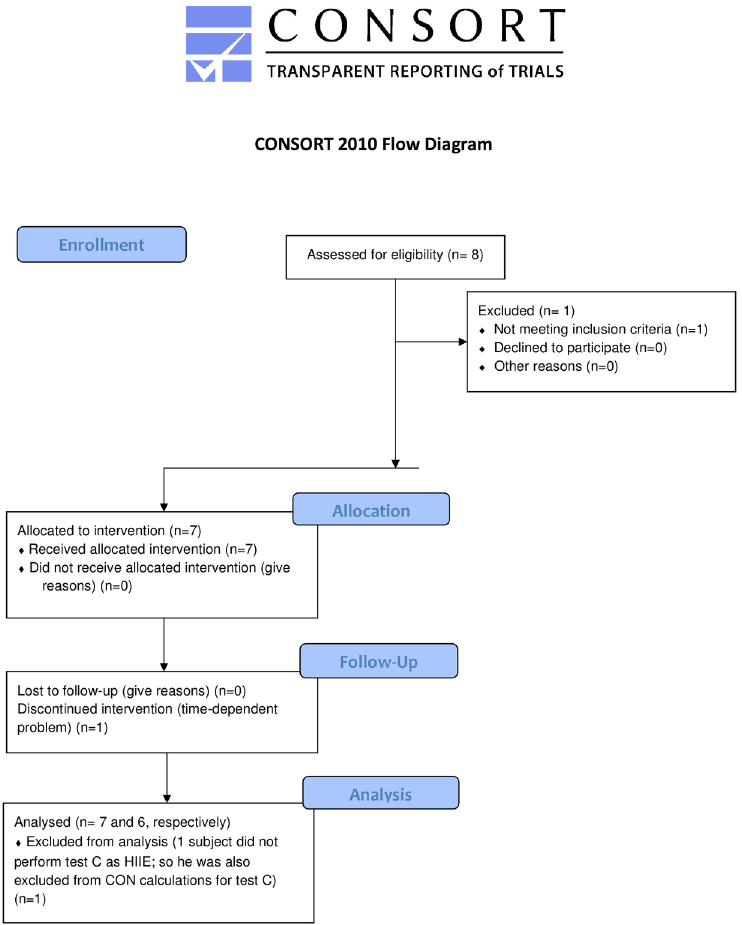
Fig 1. Consort flow diagram. CON: moderate continuous exercise, HIIE: short high-intensity interval exercise.